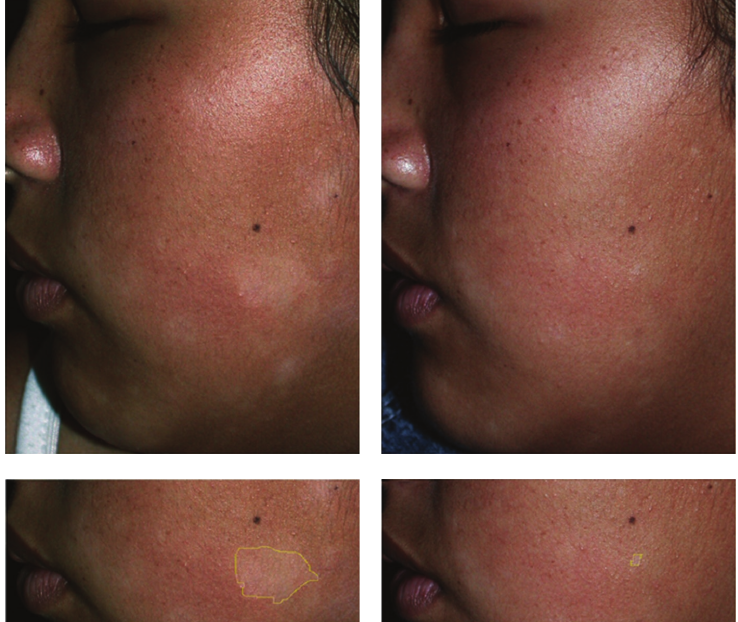
Figure 3: PA lesion treated with 0.0003 % calcitriol in a 10-year-old girl, view at onset (left) and 8 weeks later (right). In the lower picture, target lesion was outlined to measure the a ff ected area showing the excellent clinical response.